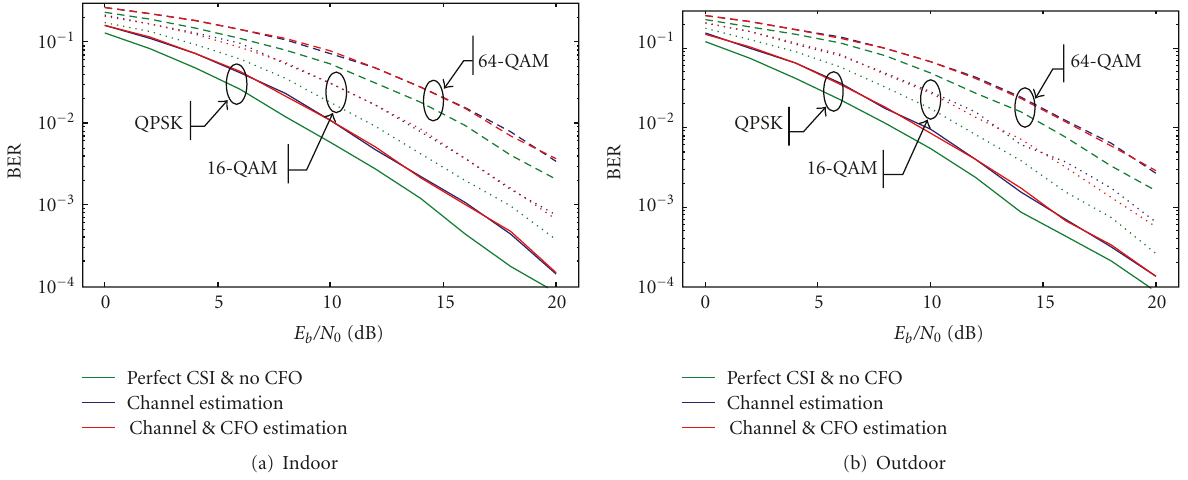
Figure 7: System BER